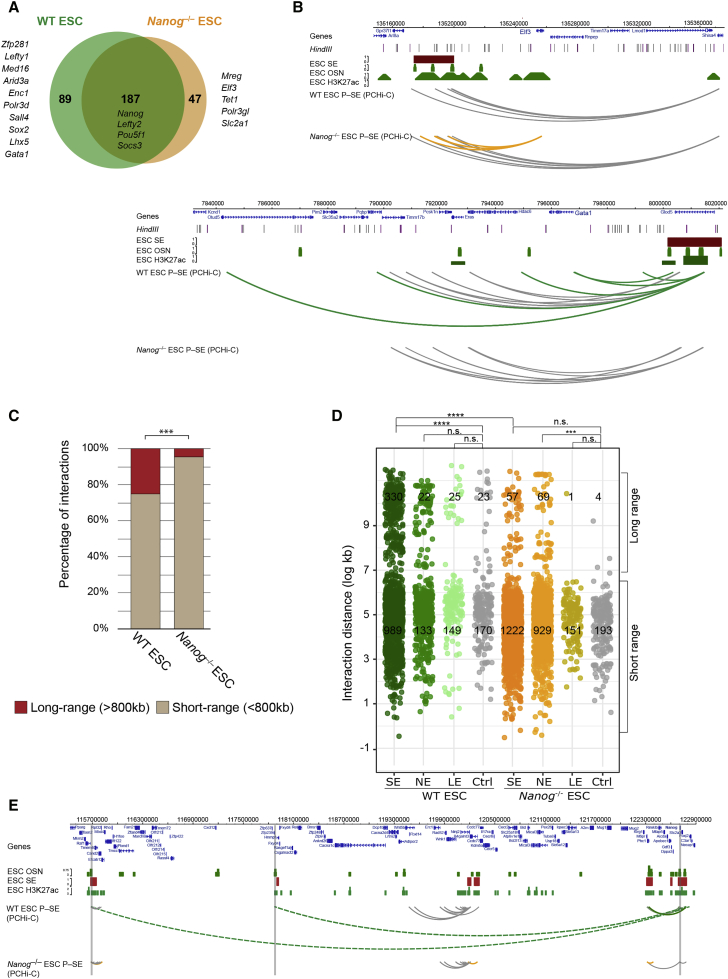
Long-Range Promoter-SE Interactions Are Depleted in Nanog-Deficient ESCs(A) Comparison of the SE-interactome between WT and Nanog−/− ESCs. The Venn diagram shows the overlap of genes that significantly interact with the 231 SEs (Whyte et al., 2013) in wild-type (WT) ESCs and Nanog−/− ESCs. A similar overlap was detected for ROSE-called WT SEs (not shown).(B) Examples of significant promoter-SE interactions in Nanog−/− ESCs (top, Elf3) and in WT ESCs (bottom, Gata1). Significant interactions common to WT and Nanog−/− ESCs are shown as gray arcs, while orange or green arcs represent interactions detected only in the knockout or in the WT ESCs.(C) The proportion of long-range promoter-SE interactions was significantly reduced in Nanog−/− ESCs compared to WT ESCs (57 versus 330 LRIs, respectively; Benjamini-Hochberg adjusted chi-square p < 0.0001).(D) The proportion of long-range versus short-range promoter-SE interactions in WT ESCs is significantly higher compared to Nanog−/− ESCs (Benjamini-Hochberg adjusted chi-square p < 1E-05). No significance in the proportion of long- versus short-range was detected between promoter-SE and promoter-CTRL in Nanog−/− ESCs.(E) Promoter-SE interactions at a large region encompassing the Nanog locus. Grey arcs show promoter-SE interactions common to both WT and Nanog−/− ESCs, and orange and green arcs represent interactions detected in each, respectively. Dashed arcs indicate LRIs. Vertical gray lines denote SE interactions at sites bound by the pluripotency transcription factors OCT4, SOX2, and NANOG (OSN).See also Figure S3 and Tables S1 and S3.